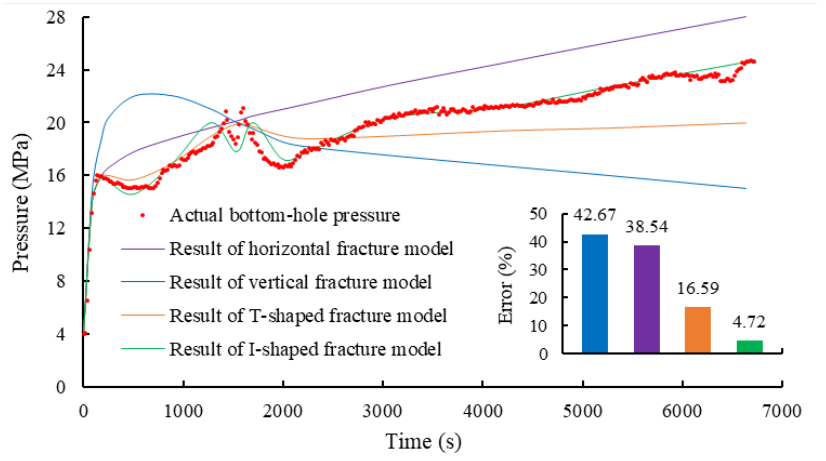
Figure 6. Comparison of bottom-hole pressure calculated by different models during fracturing treatment. Energies 2022 , 15 , x FOR PEER REVIEW 16 of 22